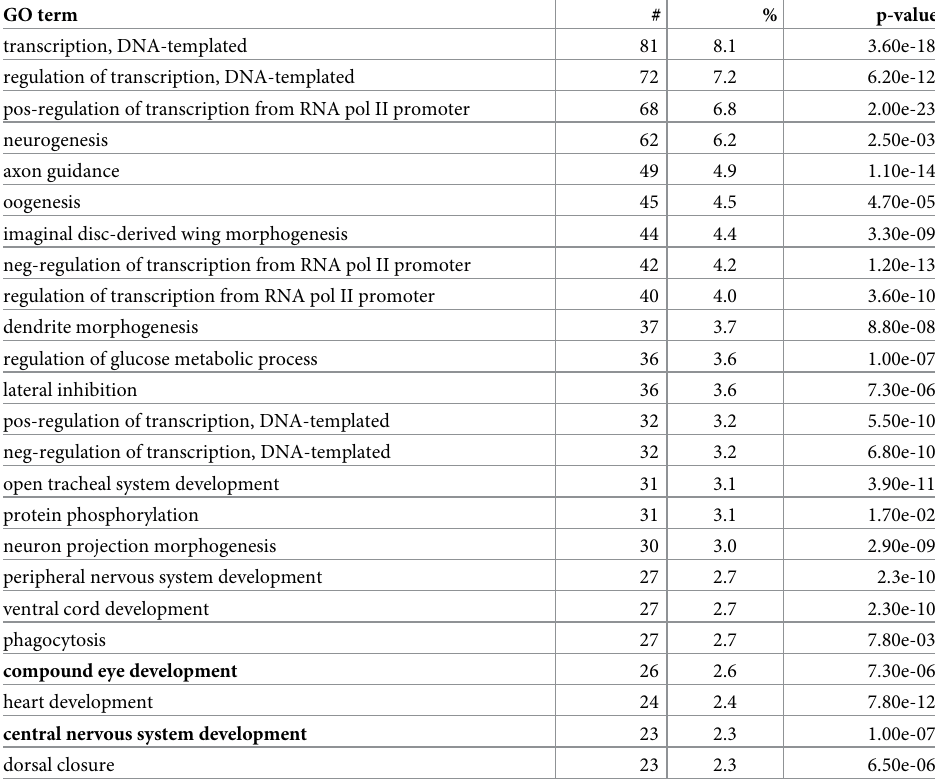
a The listed GO terms are all biological process related terms. ‘#’ denotes the number of genes annotated by the GO term, and ‘%’ denotes the percentage of gens annotated by the GO term. ‘pos-regulation’ is short for positive regulation, ‘neg-regulation’ is for ‘negative regulation’ and ‘RNA pol II’ is for ‘RNA polymerase II’.